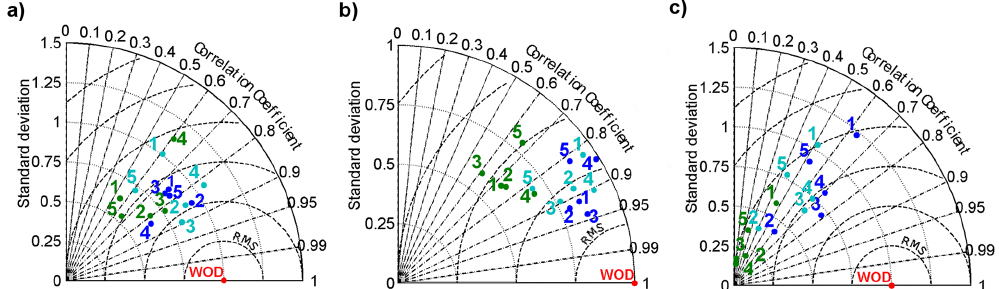
Figure 8. Taylor diagram for the period 1992–2004 within each defined layer: (a) SL (100–150m), (b) IL (409–634m), and (c) BL (3000m to the seabed); the diagrams are separated according to the ocean sectors (Fig. 1) and are indicated by numbers (Indian – 1, Western Pacific – 2, Ross Sea – 3, Bellingshausen and Amundsen sectors – 4, and Weddell Sea – 5). Dark blue, green, and light blue points indicate θ , S , and γ n , respectively. The gray curves, dashed curves, and dashed radii refer to the normalized standard deviation, centered root-mean-square error, and correlation, respectively. WOD refers to the observed data set used as a reference for the comparison (see the text for details).